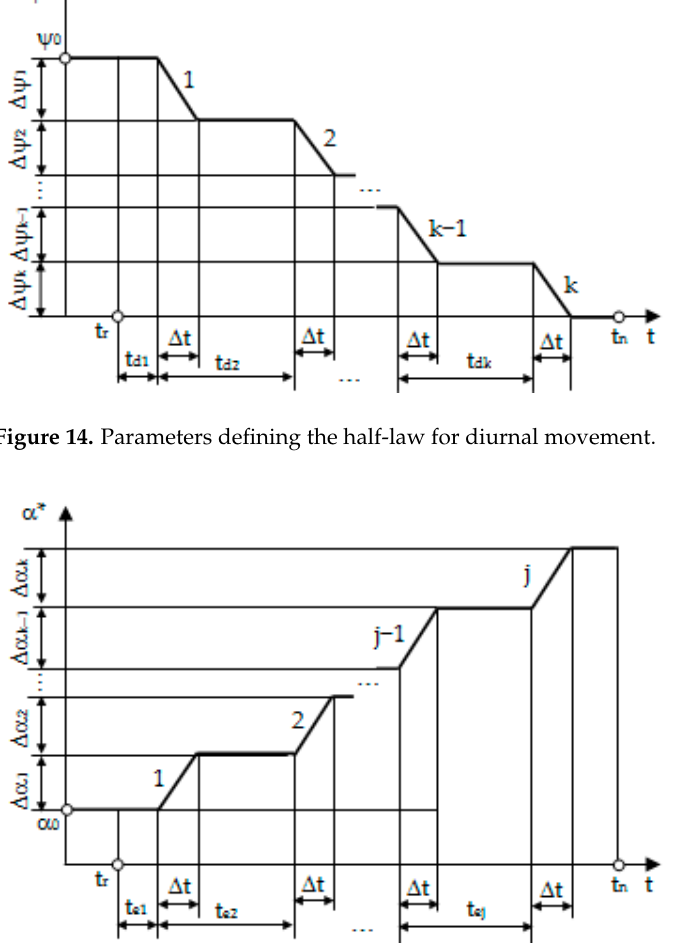
Figure 15. Parameters defining the half-law for elevation movement.